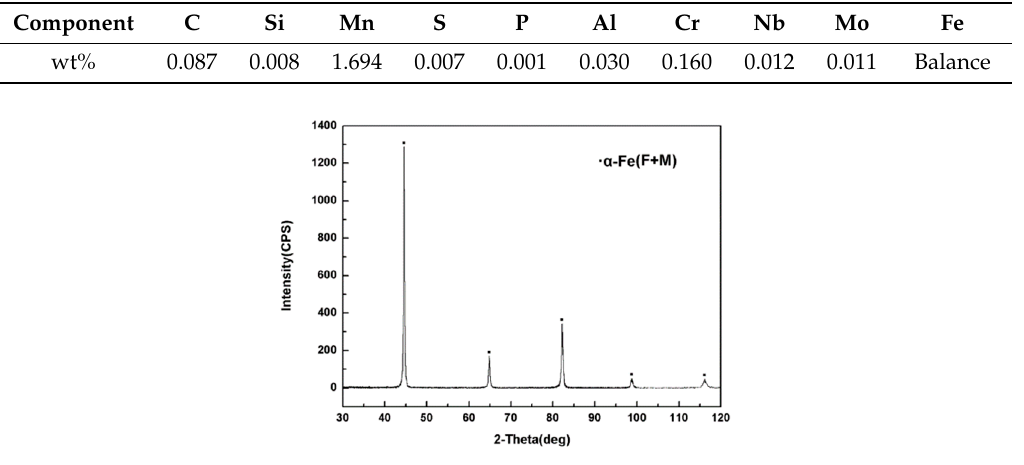
Figure 1. XRD pattern of base metal.